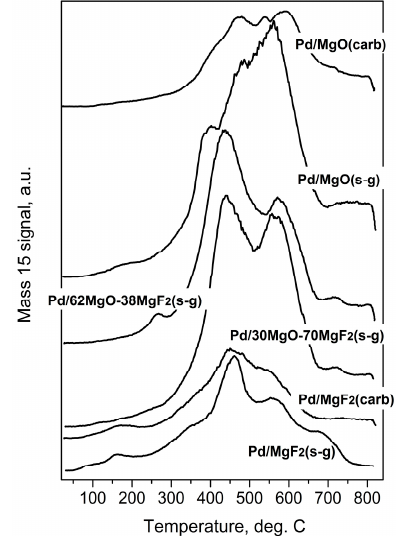
Figure 6. Temperature programmed hydrogenation of post-reaction deposits from Pd/MgO-MgF 2 catalysts. Mass 15 was selected for monitoring methane evolution because mass 16 would also reflect the signal from water.